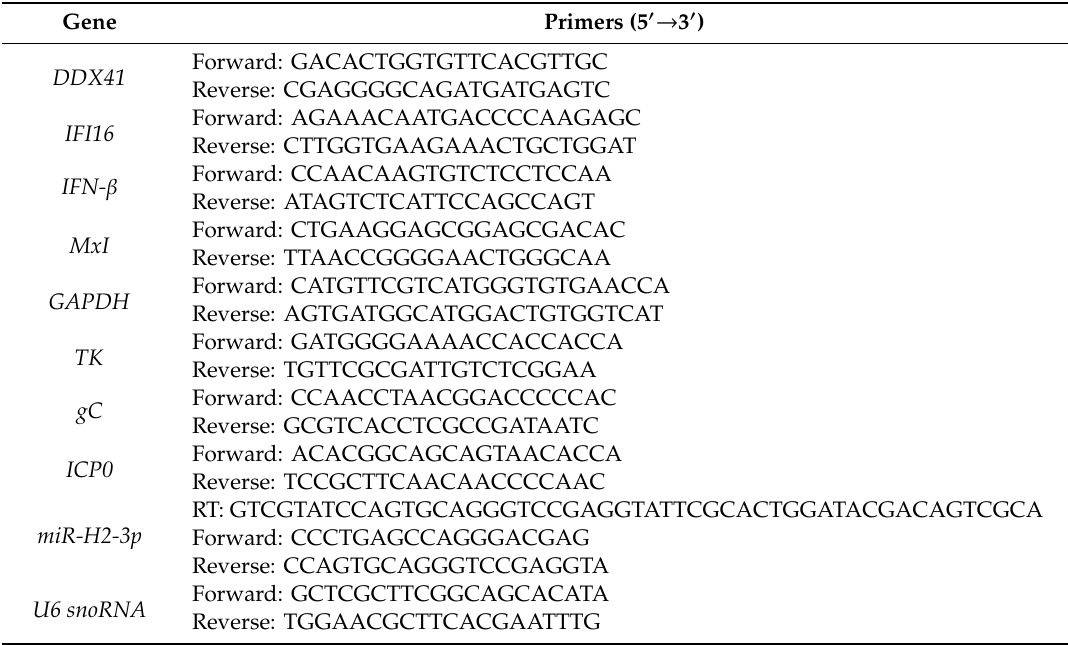
Table 4. The RT-PCR